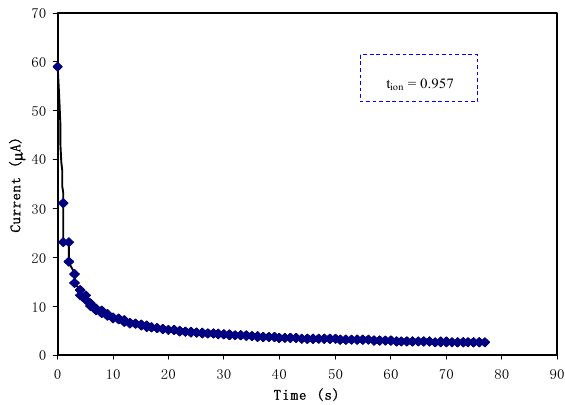
Figure 4. Polarization of the highest conducting electrolyte at 0.2 V.